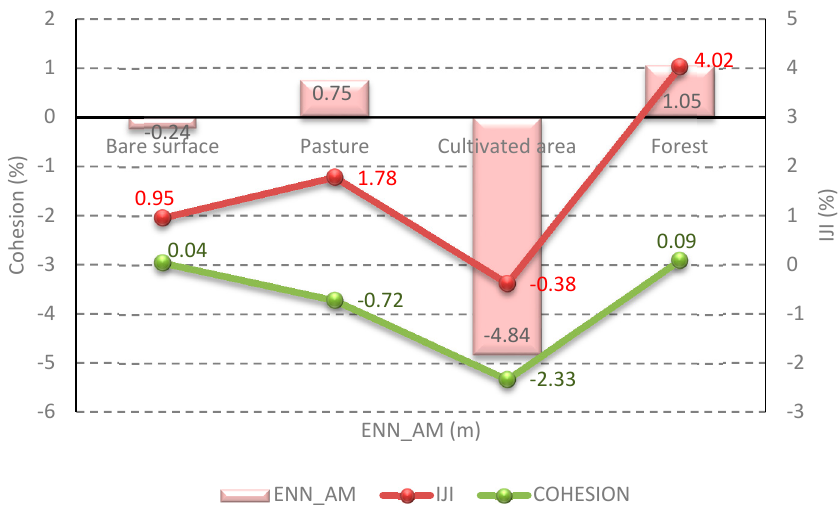
Figure 5. Gains and losses of ENN_AM, IJI and Cohesion of LULC by category in different time periods (1998–2015) in the upper part of the HSCZ.